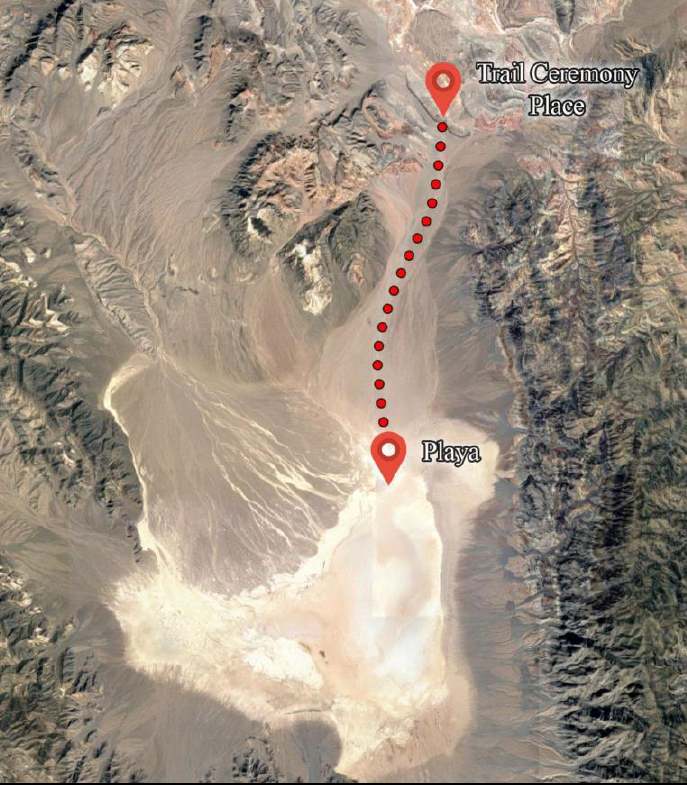
Figure 17. Desert Lake Playa (Source: Google Earth).